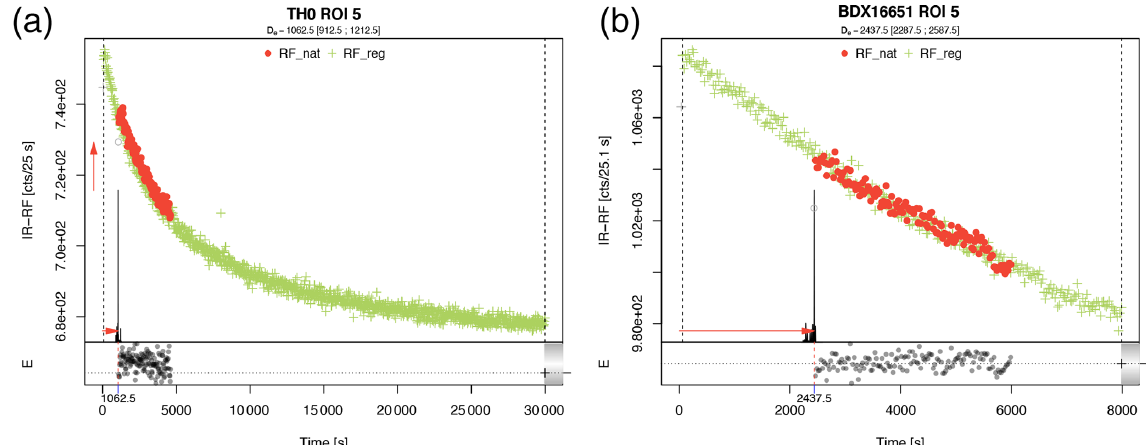
Figure 5. Typical IR-RF curves for the samples TH0 (a) and BDX16651 (b) . Both curves were extracted from ROIs following the procedure outlined in the first part of the article. For determining the D e the sliding method was used. Due to the absence of any curvature in the observed dose range, no vertical sliding was applied to sample BDX16651 measurements (b) . Please note, for sample BDX16651 only the first 8000s of the RF reg are displayed in the figure due to a technical error. SR-RF macro settings as follows: image group size: 5, noise tolerance: 20 (TH0), 30 (BDX16651), grain diameter: